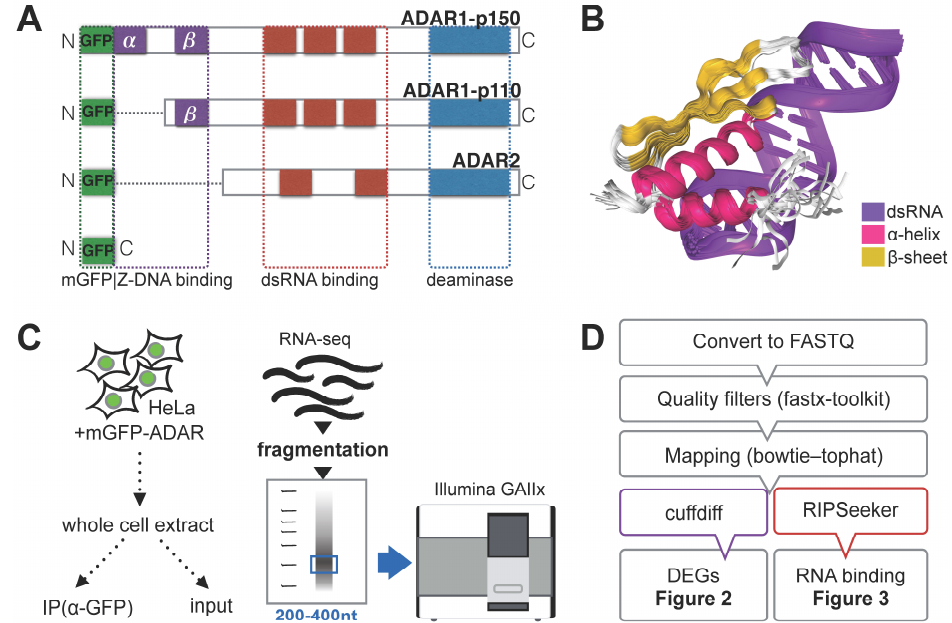
Figure 1. Experimental and computational workflow for RNA immunoprecipitation (RIP)-sequencing. ( A ) Schematic representation of known domains within adenosine deaminase acting on RNA (ADAR) enzyme isoforms with a catalytically-active deaminase domain. The final fusion proteins used in this experiment all harbor myc-green fluorescent protein (GFP) (mGFP) in the N-terminal region (left side in this figure). The dots within the protein sequence do not represent any real protein were added in order to align and visually compare similar domains. Purple: Z-DNA binding domains;